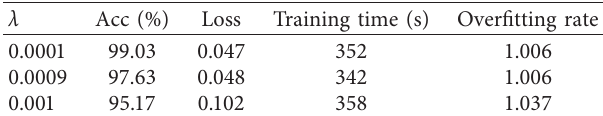
Figure 10: Comparison of training loss value of different atten- uation coefficients. Table 3: Influence of different attenuation coefficients on the training effect of deep reconstruction network